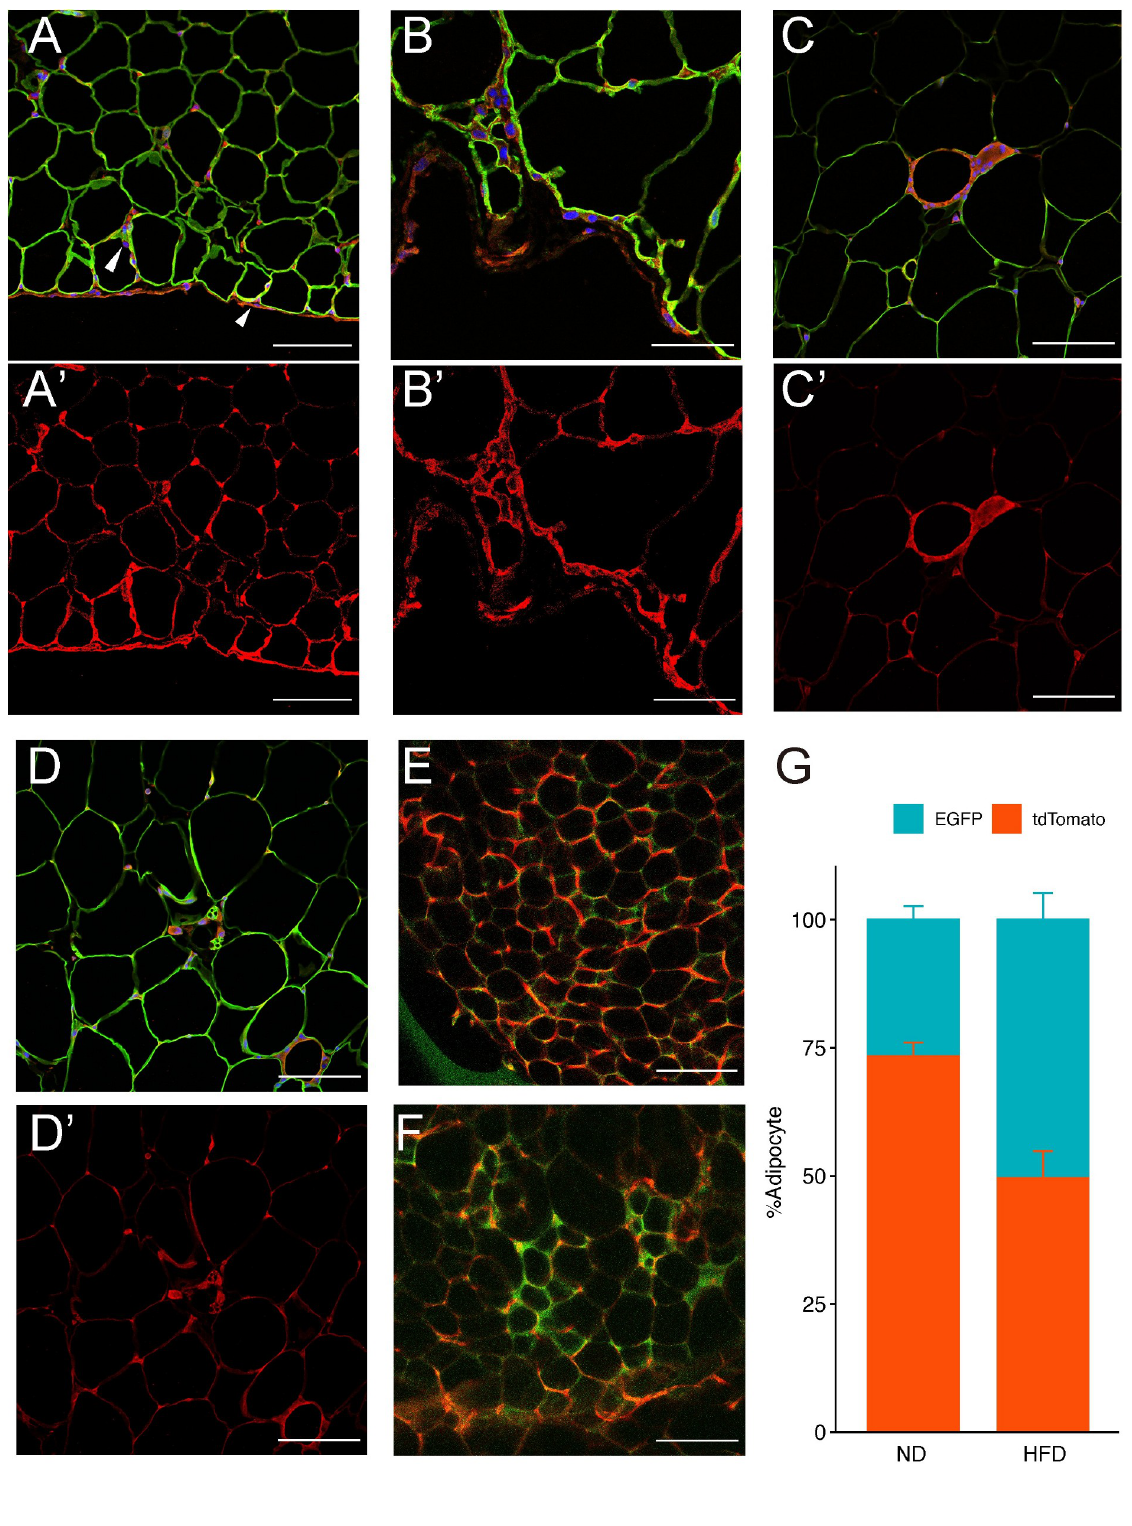
Fig 3. Adipose tissue lineage tracing. Meflin -CreER T2 /Rosa26-tdTomato mice were fed a normal diet for 4 weeks (ND 4w) or a high-fat diet for 8 weeks (HFD 8w) and gonadal WAT (gWAT) samples were examined. WAT was stained with the adipocyte markers perilipin (green),